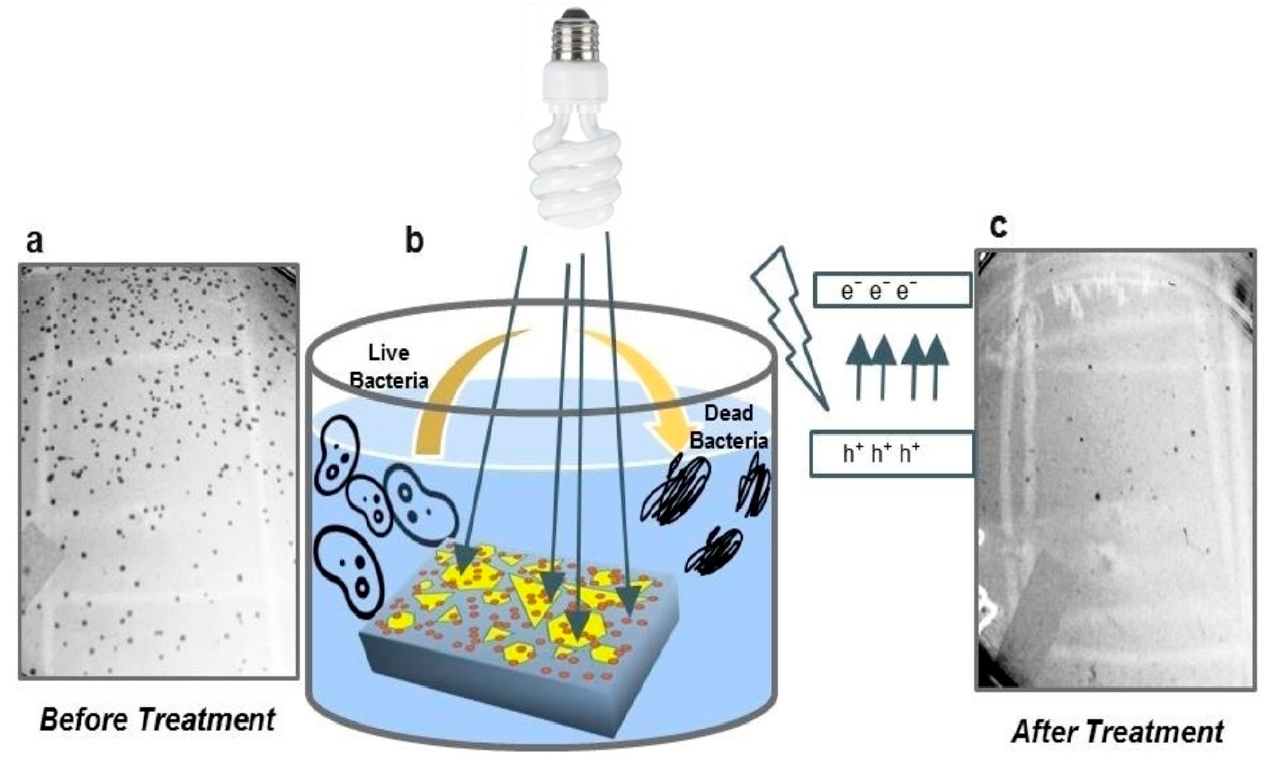
Figure 3. Schematic illustration of the photo-antibacterial activity of Ag–WS 2 ( a ) before treatment, ( b ) Ag–WS 2 exposed to the bacteria, and ( c ) after treatment. The image was taken with permission [68]. Kiani et al. synthesized rGO-decorated CuO nanowires (rGO–CuO–NW) using